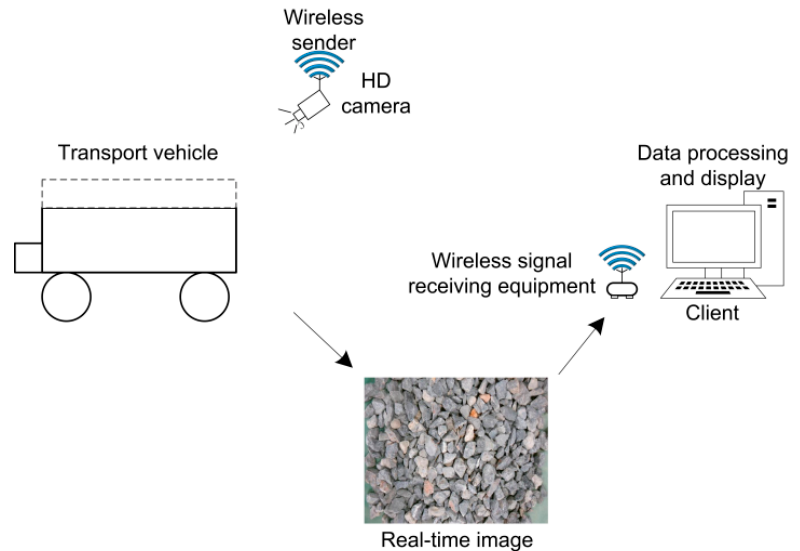
Figure 1. Image acquisition process: after the transport vehicle arrives, the aggregate image is collected, and the model returns the result after processing.